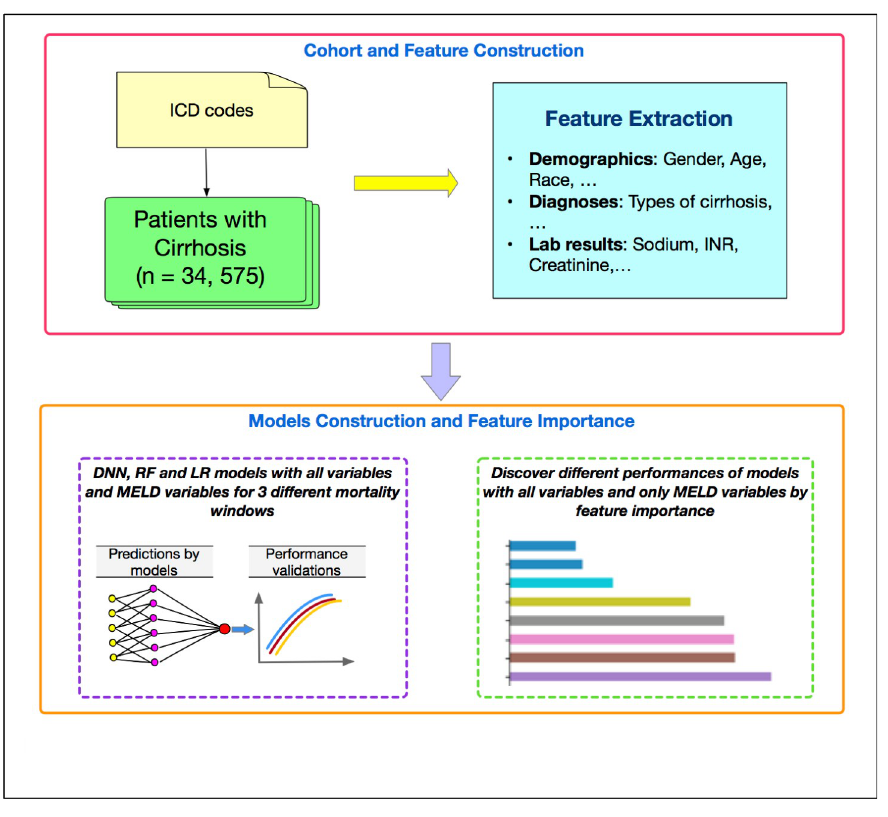
Fig 1. The flowchart of our